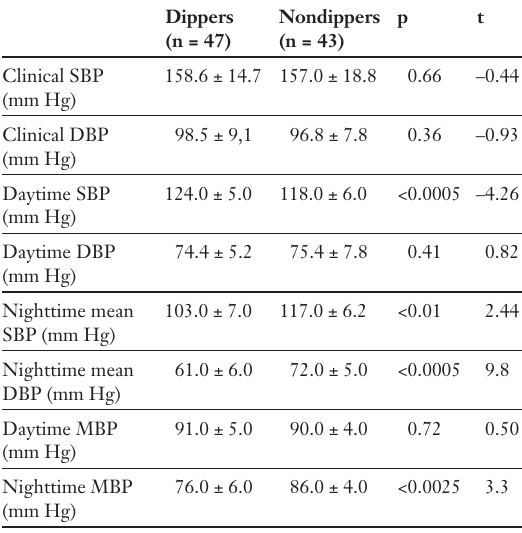
Clinical and ambulatory blood pressure measurements.